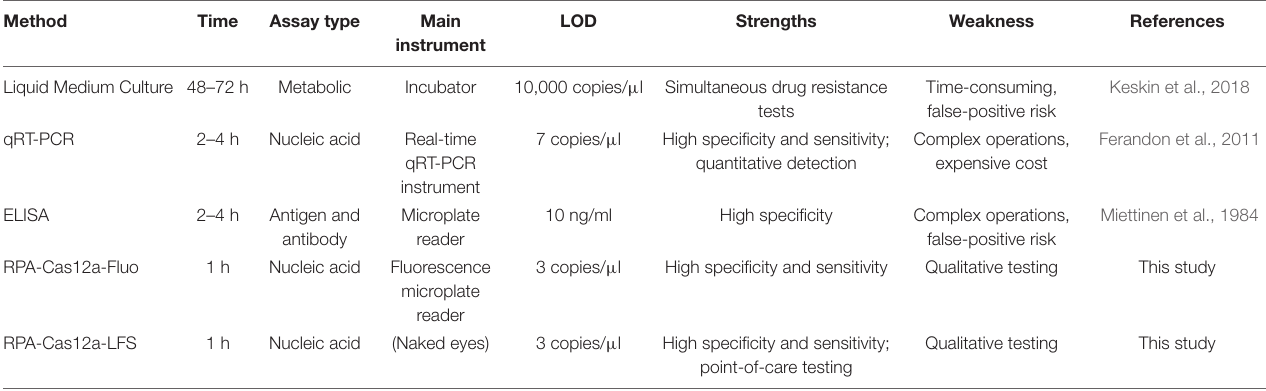
TABLE 2 | Comparison of different detection methods for M. hominis .